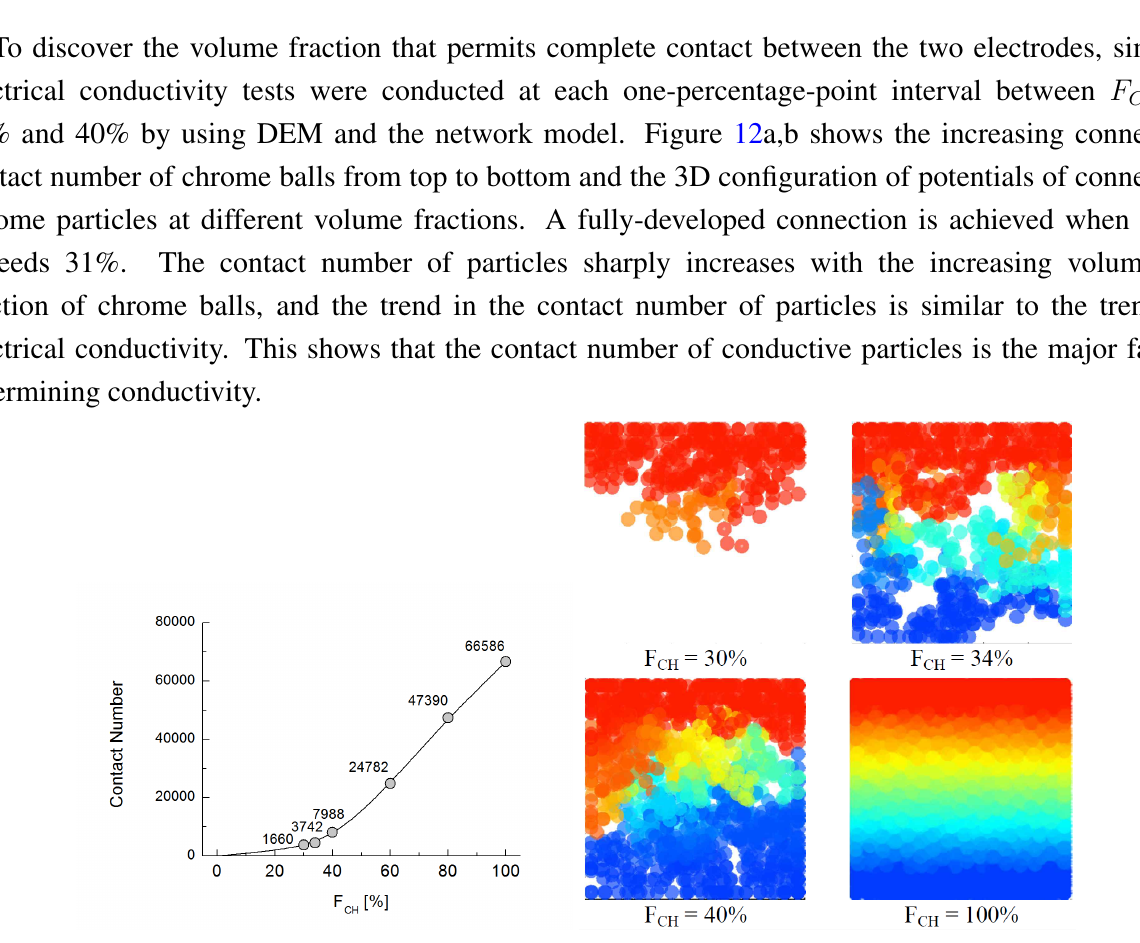
Figure 11. ( a ) Potential distribution ofthe chrome balls with respect to the height for Case 1: F = 60% at the steady-state condition. ( b ) Distribution of estimated electrical conductivity CH with respect to the height for different fractions of chrome balls.